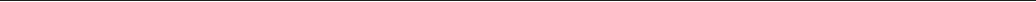
Table 1. K14 cre miR-21 fl / fl were obtained by cross breeding mir-21 fl / fl mice (kind gift from Dr. Eric Olson) with K14 Cre mice (Jax # 005107). Depletion of miR-21 was performed by intra peritonial injection of tamoxifen for 2 weeks at dose 75mg kg − 1 body weight. PCR for K14 cre miR-21 fl / fl mice was con fi rmed using primers tabulated in Supplementary Table 1. LysM cre miR-21 fl / fl were obtained by cross breeding mir-21 fl / fl mice with LysM Cre mice (Jax # 004781). PCR for LysM cre miR-21 fl / fl mice was con fi rmed using primers tabulated in Supplementary Table 1. Eight-week-old C57BL/6 mice were purchased from Harlan laboratories. Lepr db/db mice homozygous (BKS.Cg-m + / + Lepr db/J 482, or db/db; stock no 000642) for spontaneous mutation of the leptin receptor (Leprdb) (aged